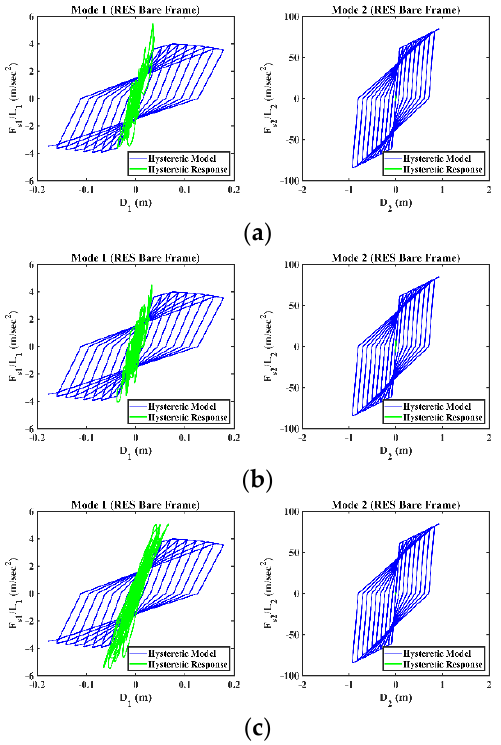
Figure 15. The hysteretic models of the RES bare frame versus the hysteretic response of idealized inelastic SDOF systems to three ground motions: ( a ) Imperial Valley; ( b ) Kobe; ( c ) Landers.